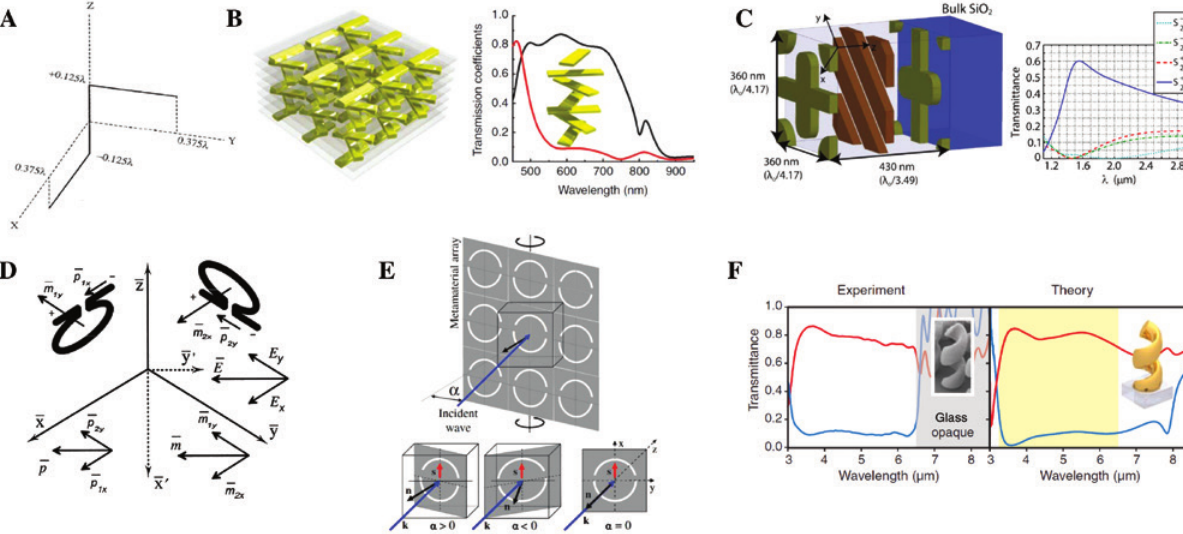
Figure 7: Circular-polarization-selective metasurfaces. (A) Design for Pierrot’s unit cell of an artificial circular-polarization-selective surface. Reprinted figure from [141]. Copyright (1996) by IEEE. (B)